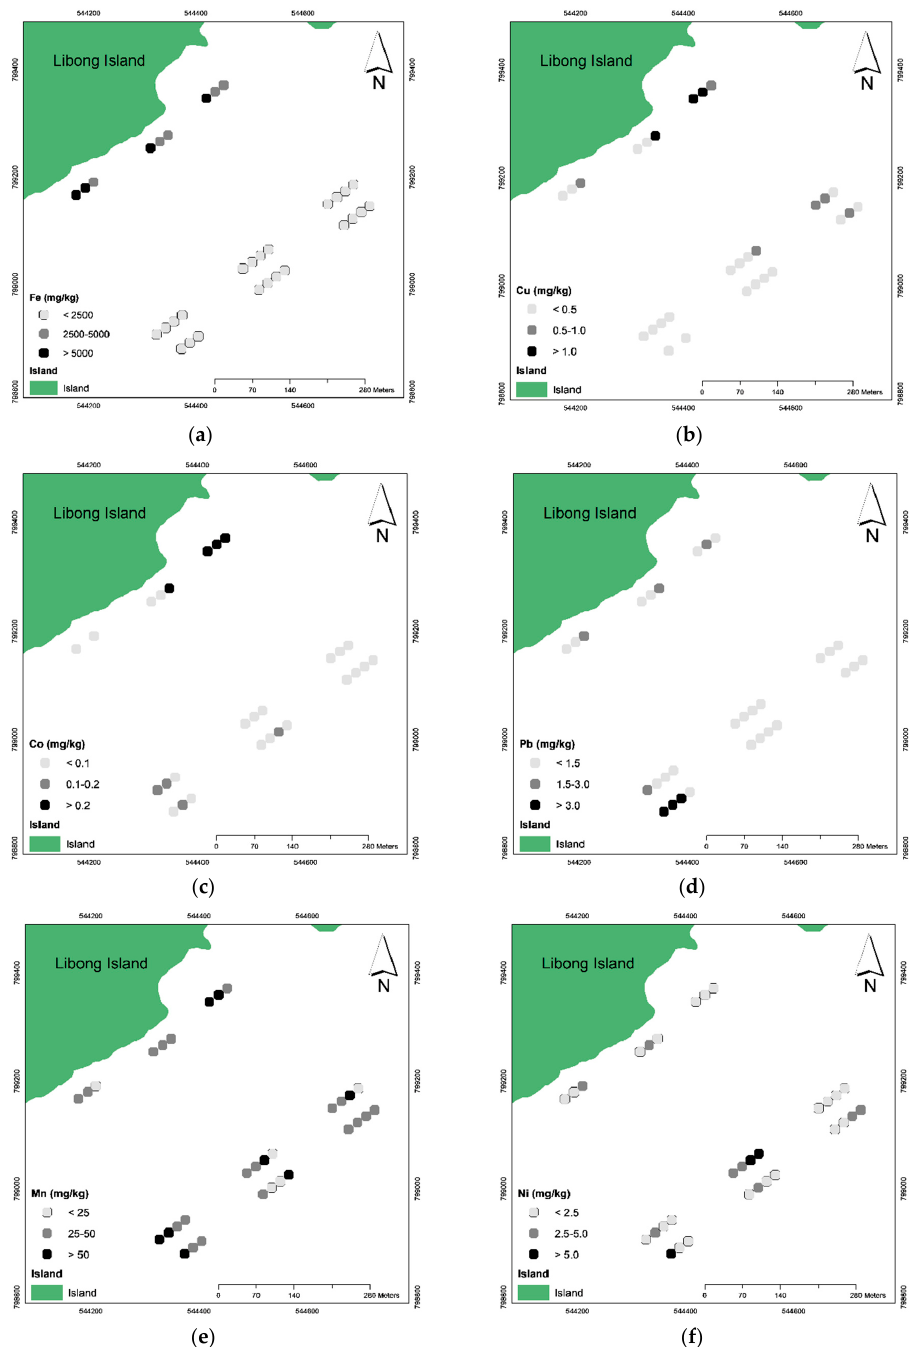
Figure 2. The trace metal distribution at Libong Island when ( a ) Fe, ( b ) Cu, ( c ) Co, ( d ) Pb, ( e ) Mn, and ( f ) Ni. Noted: detection limit of Fe, Cu, Co, Mn, Pb, and Ni is 0.1 mg/kg.